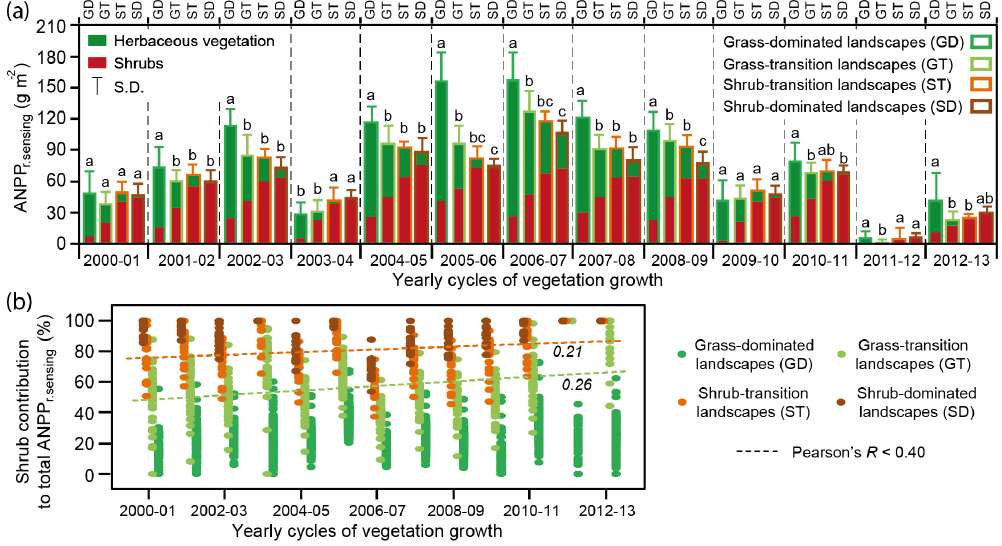
Figure 6. Spatiotemporal dynamics of remotely sensed ANPP: (a) ANPP differences between landscape types (grass-dominated, grass- transition, shrub-transition, and shrub-dominated landscapes) over 2000–2013 and (b) 2000–2013 temporal variations of the shrub contribu- tion to total ANPP for the different landscape types (Pearson’s R correlations of shrub ANPP contributions with time). Different letters in panel (a) for each cycle of vegetation growth indicate significant differences between landscape types at P < 0 . 05 (tested using repeated- measures ANOVA and post hoc Tukey HSD tests). Dotted lines in panel (b) represent weak ( R < 0 . 40) correlations. Displayed correlations are significant at P < 0 . 05. Numbers in plot (b) indicate correlation